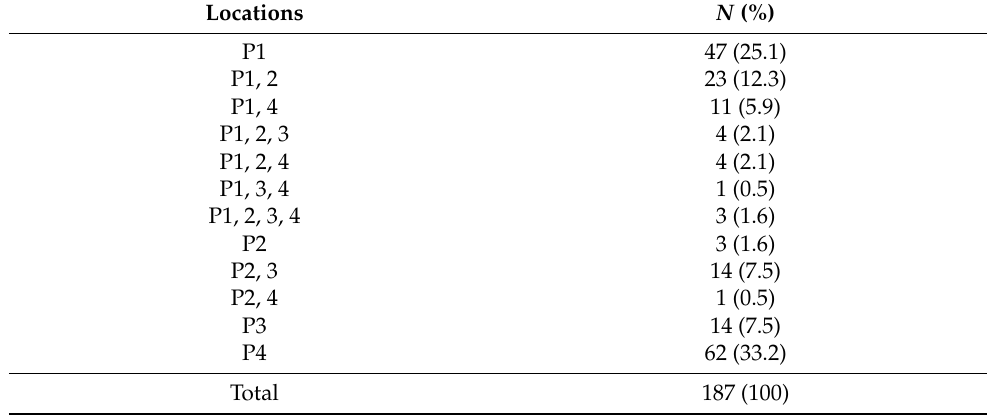
Table 1. Primary tumor locations.